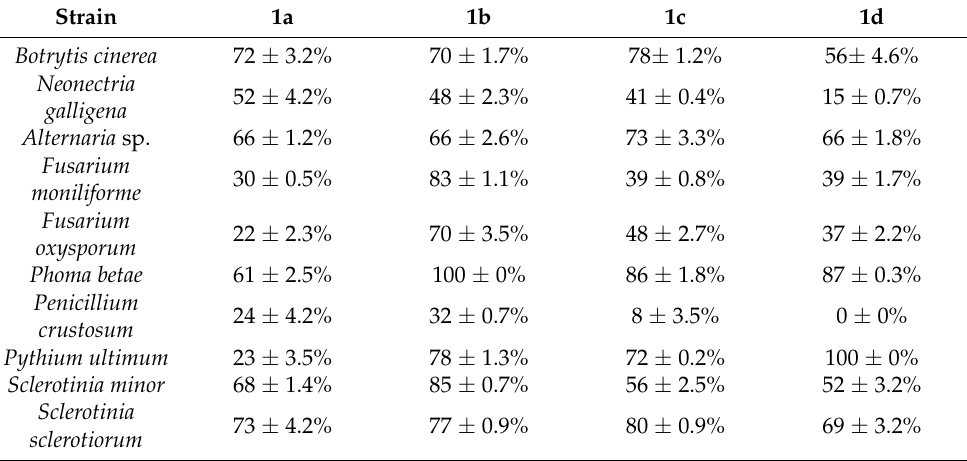
Table 3. Antifungal activity screening obtained with secosteroids.